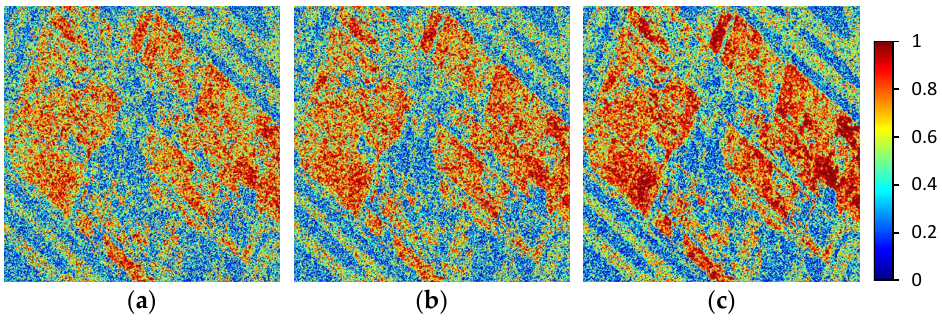
Figure 11. Coherence maps generated by the three methods: ( a ) the standard method; ( b ) the IPS-Based method; ( c ) the proposed method.